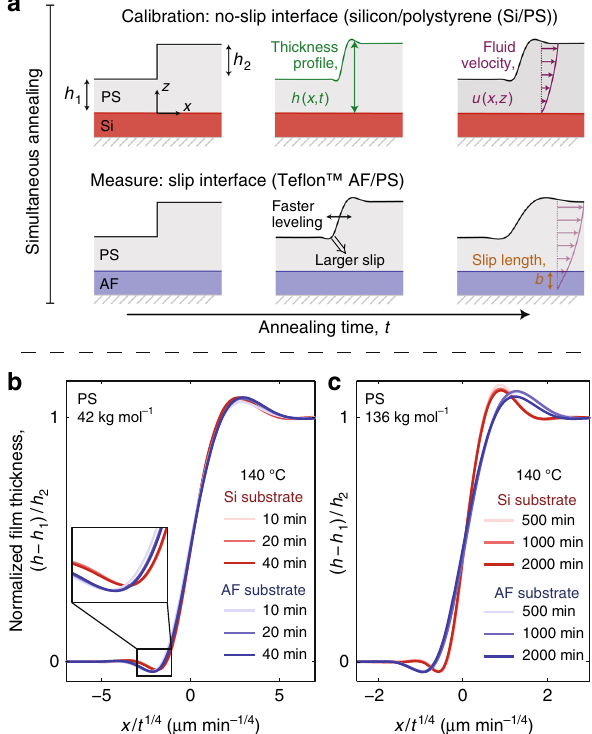
Fig. 1 Capillary leveling experiments on different substrates. a Schematic of the experimental procedure in which identical PS samples on two different substrates are annealed simultaneously. b , c Temporal series of experimentally measured atomic force microscopy pro fi les, normalized to demonstrate self-similarity of the fi lm thickness pro fi les. Interfacial slip causes a faster broadening of the fi lm thickness pro fi